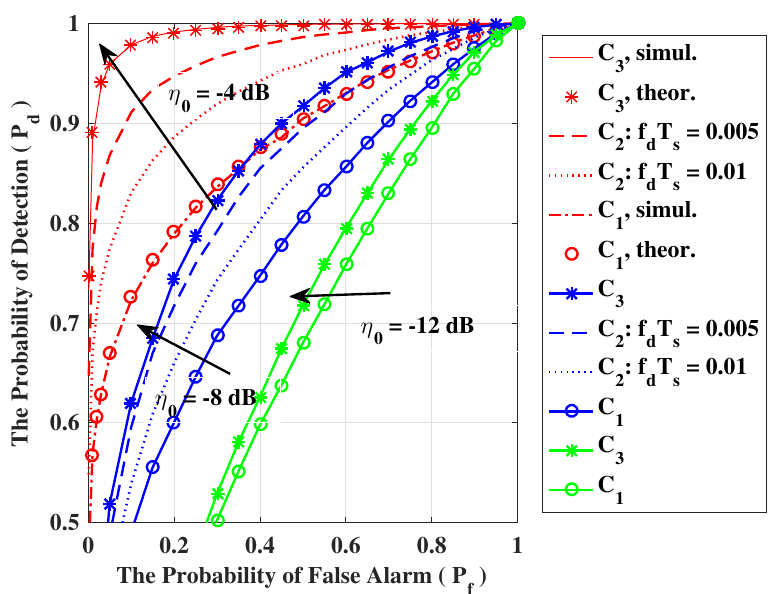
Figure 6. The ROC curves of local sensing for various average SNR ( N = 1, K =